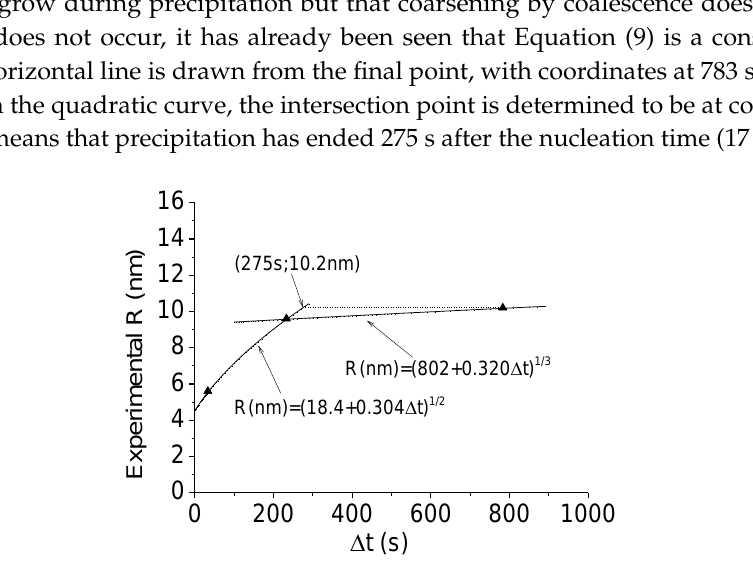
Figure 8. Experimental growth and coarsening of precipitates.